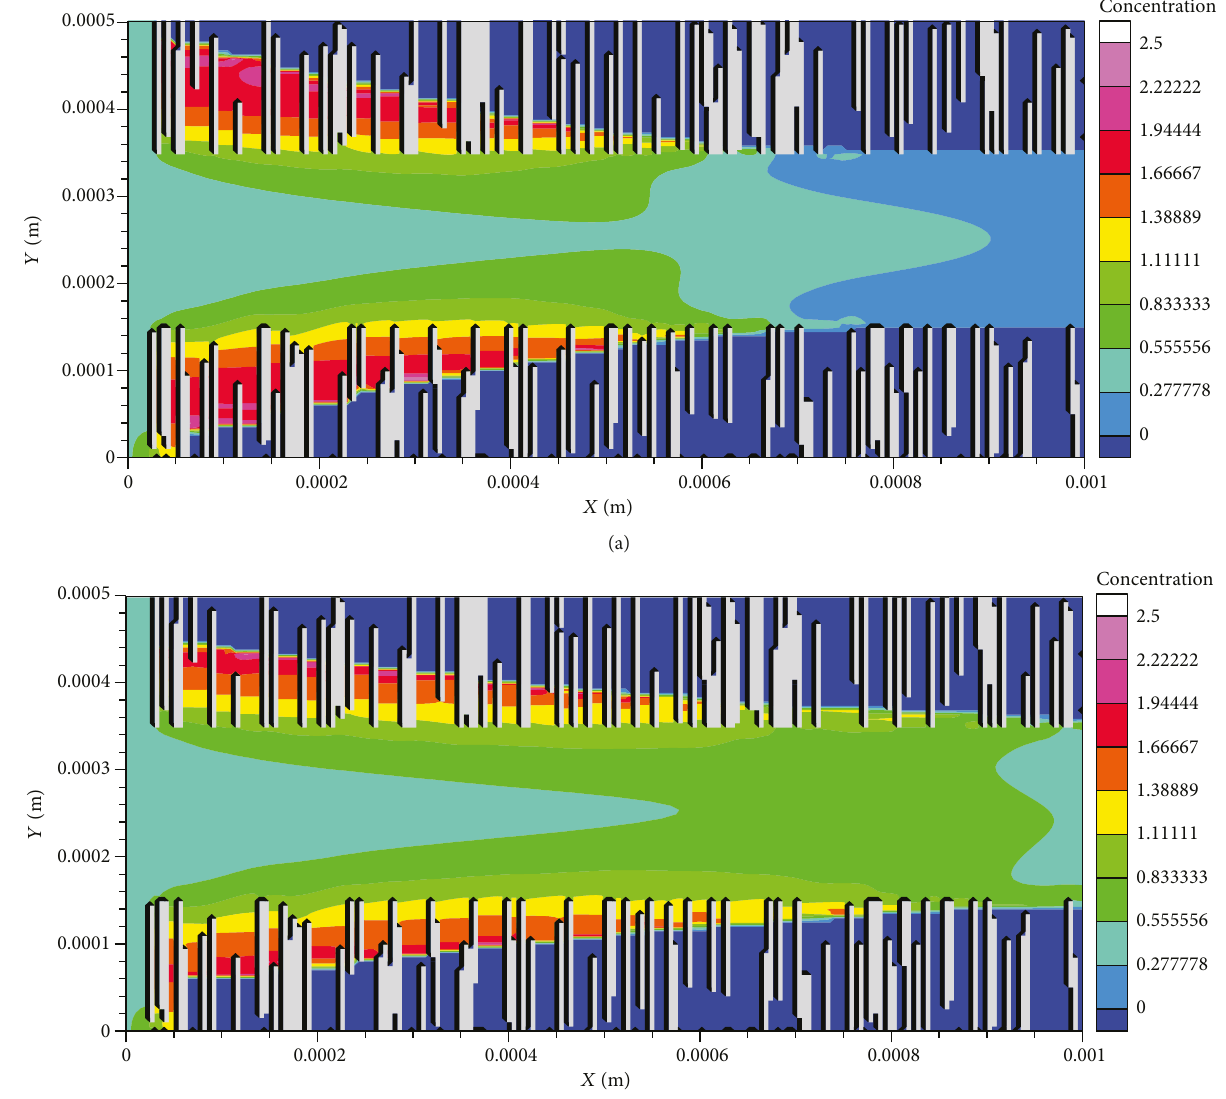
Figure 12: Concentration (mol/L) of species A when (a) Pe =26 and Da =20 and (b) Pe =26 and Da=10. In both (a) and (b), porosity (aq) (after dissolution) is near 0.52 but permeability (after dissolution) is 1.39 × 10 − 9 m 2 for (a) and 1.43 × 10 − 9 m 2 for (b). The nonreactive are representing reactive minerals are illustrated in light gray. The areas showing a zero concentration of species A (aq)